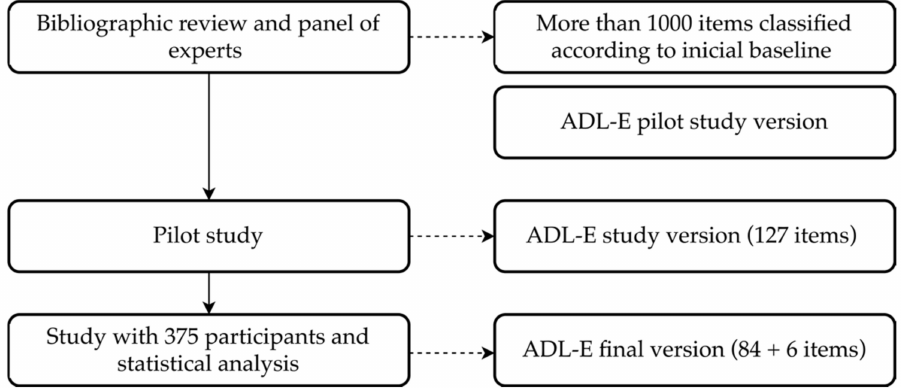
Figure 2. Activities of Daily Living Evaluation in Schoolchildren (ADL-E) creation